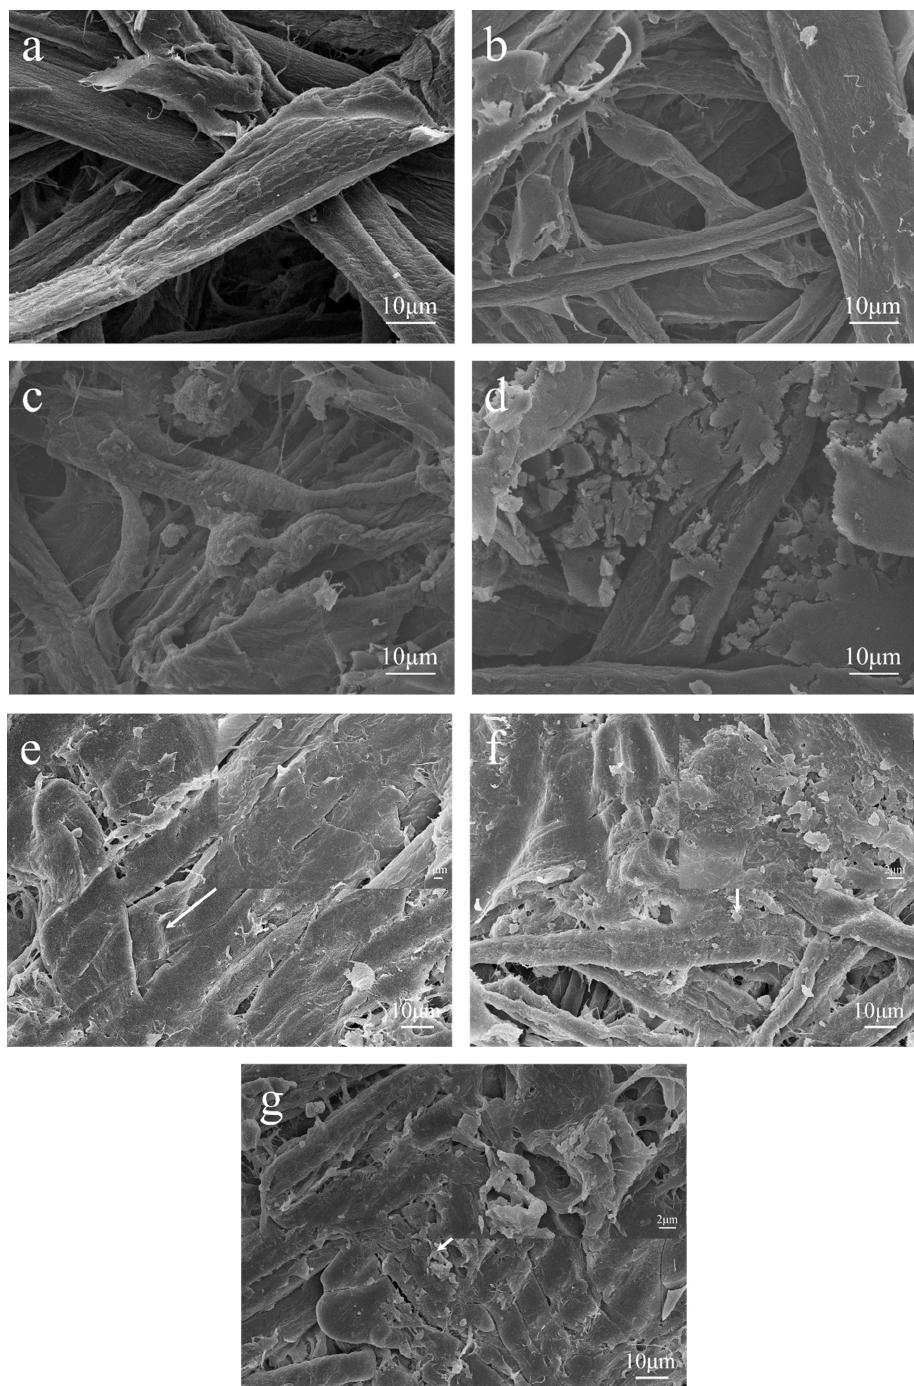
Figure 6. SEM images of the various MFP samples at ×2000 magnification: ( a ) CS; ( b ) CCS; ( c ) ES; ( d ) HES; ( e ) LS; ( f ) ELS; ( g ) HELS.